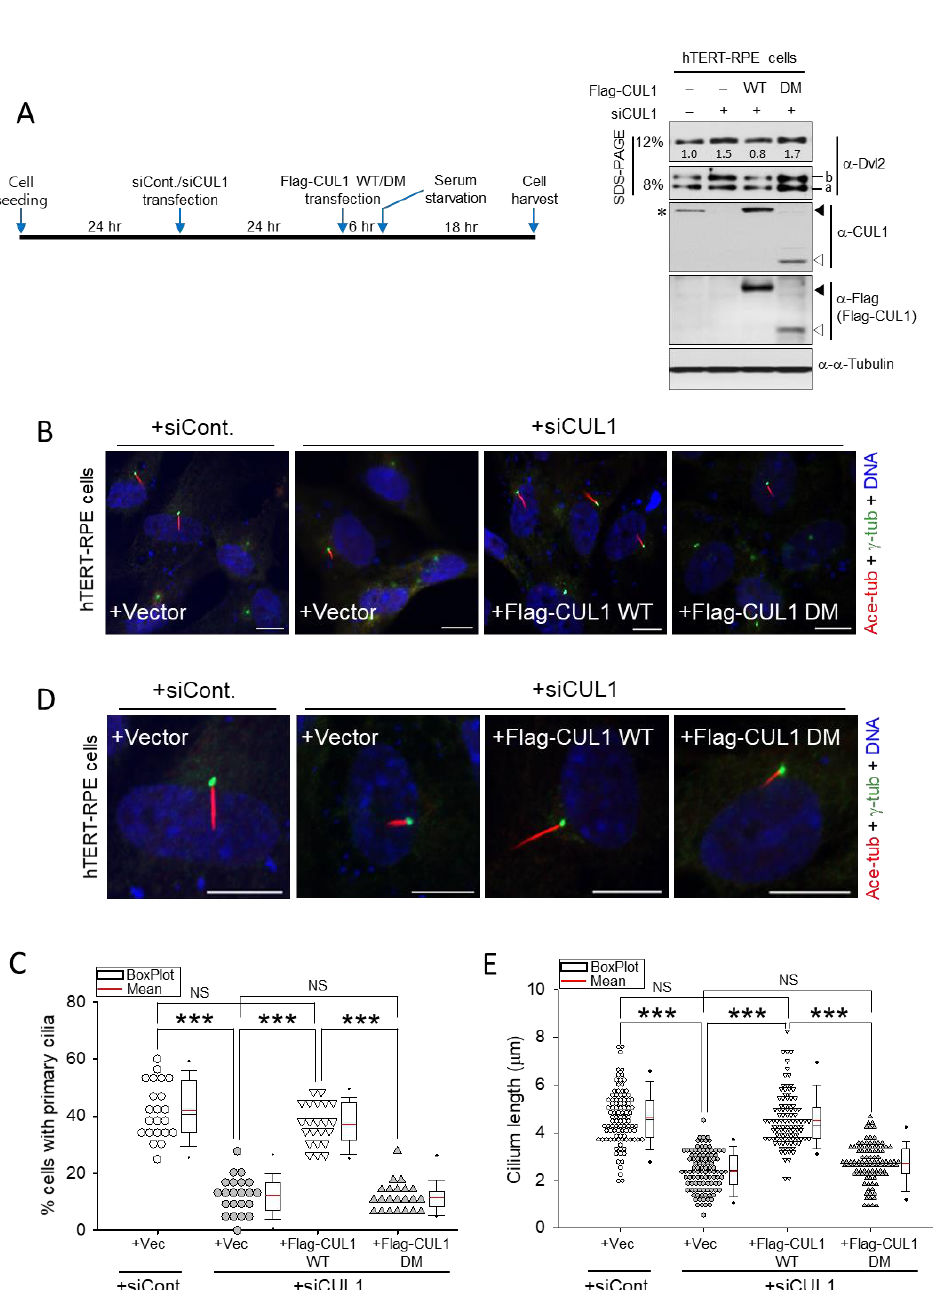
Figure 6. Restoration of primary ciliogenesis by CUL1 expression in CUL1-depleted hTERT-RPE cells. ( A ) hTERT-RPE cells transfected with either control or CUL1 siRNA were transfected with control vector (-), pFlag-CUL1 WT (WT) or DM (DM). Cells were then serum-starved for 24 h according to the experimental schedule ( left ). The resulting cell lysates were subjected to immunoblotting analysis with the indicated antibodies ( right ). Immunoblotting with the anti- α -tubulin antibody represents the loading control of proteins. The band intensities of endogenous Dvl2 were measured using ImageJ and normalized to α -tubulin, and the relative values are marked below the bands. Fast- and slow-migrating Dvl2 forms are referred to as the “a” and “b” forms, respectively. Asterisk indicates endogenous CUL1. The filled or empty arrowhead indicates the Flag-CUL1 WT or DM, respectively. ( B – E ) The same conditioned cells as in ( A ) were subjected to immunostaining with anti-acetylated α -tubulin and anti- γ -tubulin antibodies ( B , D ). Scale bar, 10 µ m. DNA was stained with DAPI. Cells containing primary cilia were counted ( B , C ), and the length of each primary cilium was measured ( D , E ). Each symbol in the dot-density graph represents a percentage (%) of ~30 cells ( C ). More than 100 cells were measured to determine the length of cilia ( E ). *** p < 0.001; NS, not statistically significant (one-way ANOVA). All data show representative images of three independent